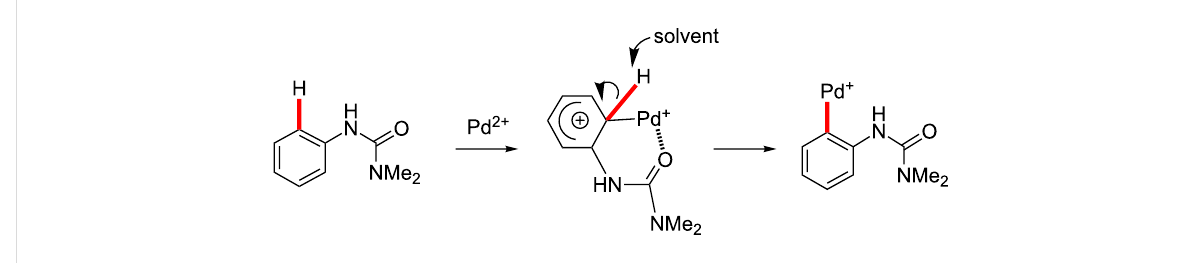
Scheme 11: Electrophilic substitution of aromatic hydrogen by cationic palladium(II) species.